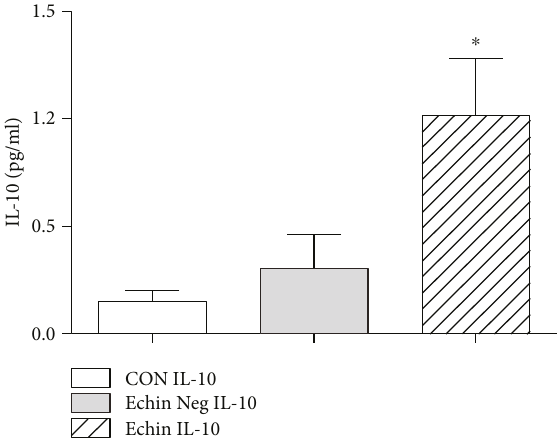
Figure 3: Serum levels of IL-10 in the group of infected patients (Echin IL-10) are signi fi cantly increased ( p < 0 05 ) in comparison to the IL-10 concentration evaluated in the group of Echinococcus - negative patients (Echin Neg IL-10) and in the group of control subjects (CON IL-10). ∗ p < 0 05 versus CON, after ANOVA and Fisher PLSD test.